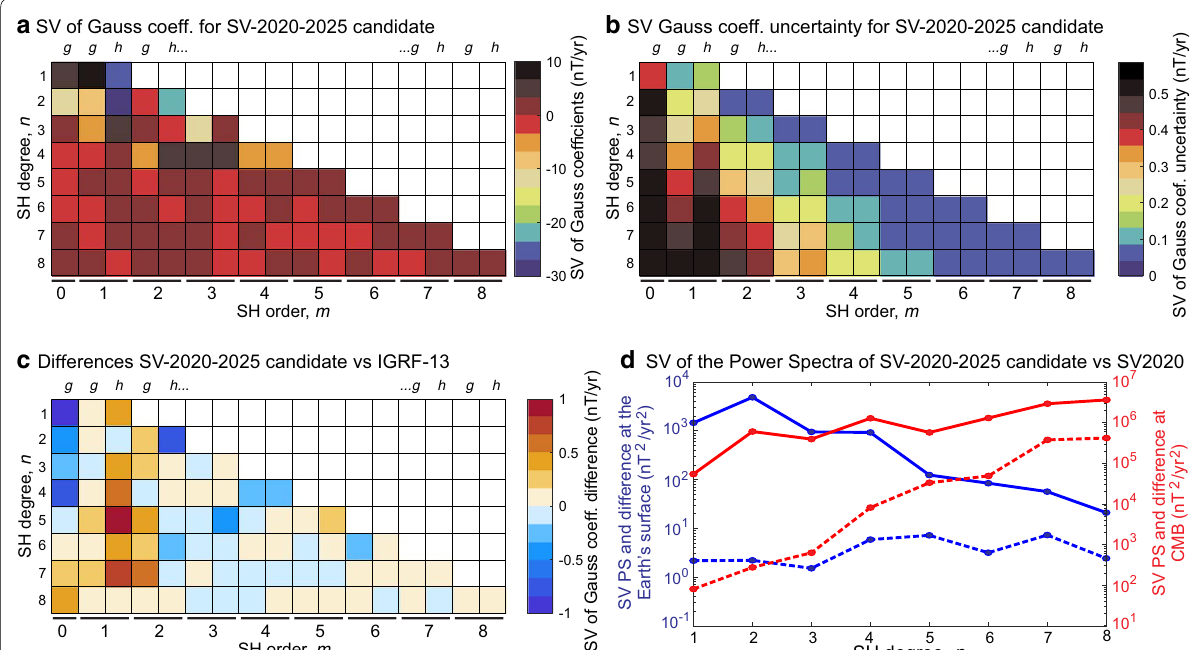
Fig. 12 SV candidate model. a Secular variation of the Gauss coefficients and b their uncertainties given by the 1‑σ of their normal distributions. c Secular variation of the Gauss coefficient differences between our SV candidate and the published SV‑2020‑2025 model. d Secular variation of the power spectrum at the Earth’s surface (blue line referred to the left y ‑axis) and at the CMB (red line referred to the right y ‑axis). Differences of the secular variation of the power spectrum between our candidate and the SV‑2020‑2025 model is also given by dashed lines (blue at Earth’s surface and red at